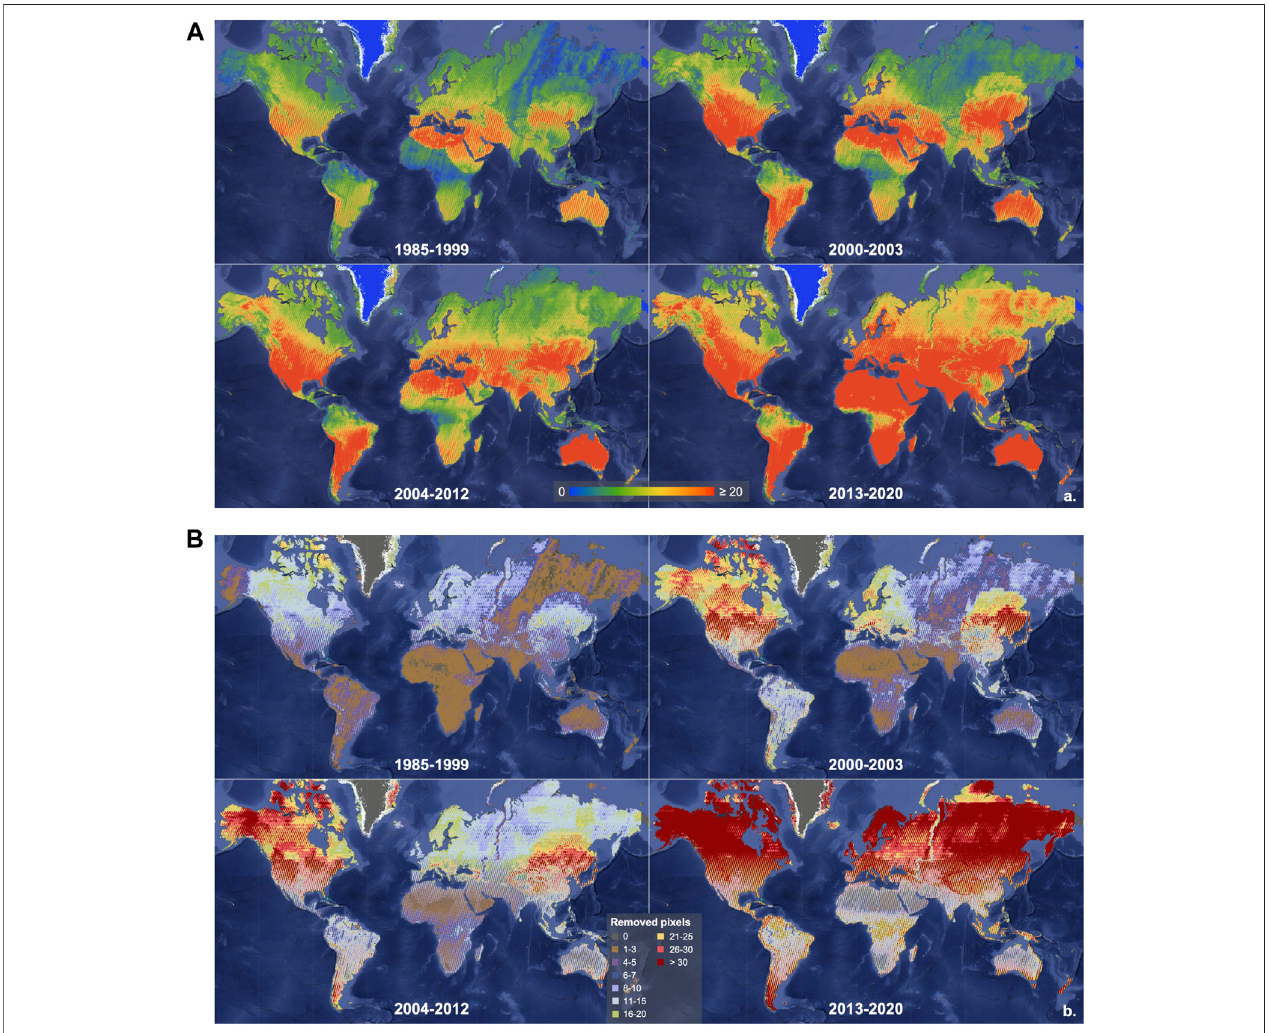
FIGURE 2 | (A) Average number of clear observations per year in four time periods 1) 1985 – 1999 (upper-left); 2) 2000 – 2003 (upper-right); 3) 2004 – 2012 (bottom- left); 4) 2013 – 2020 (bottom-right). (B) Average number of observations removed per year by applying the pixel quality fi lter. 1) 1985 – 1999 (upper-left); 2) 2000 –